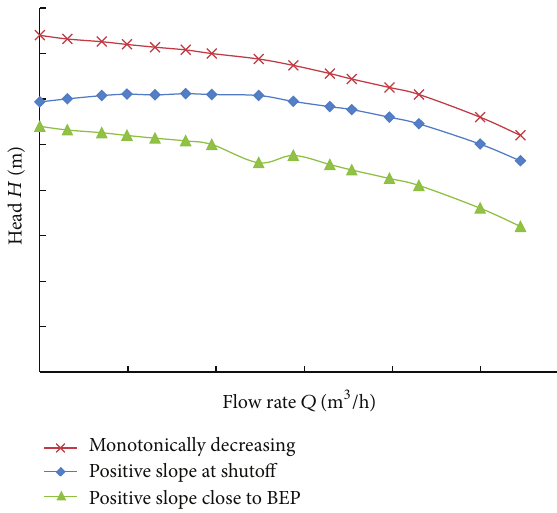
Figure 2: Typical pumping characteristics. a head-flow performance curve. Three typical